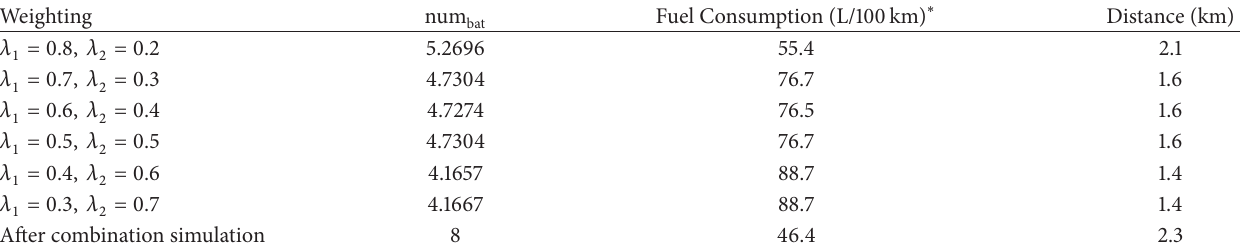
Table 2: The data of different weighting after the combination simulation.